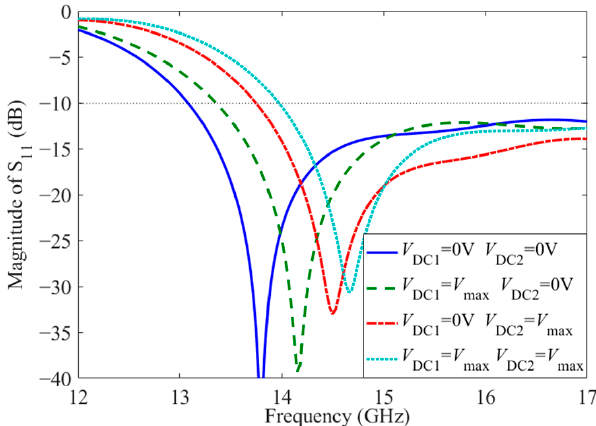
Figure 5. Magnitude of S 11 of the CRLH unit cell under dual-tuned mode of